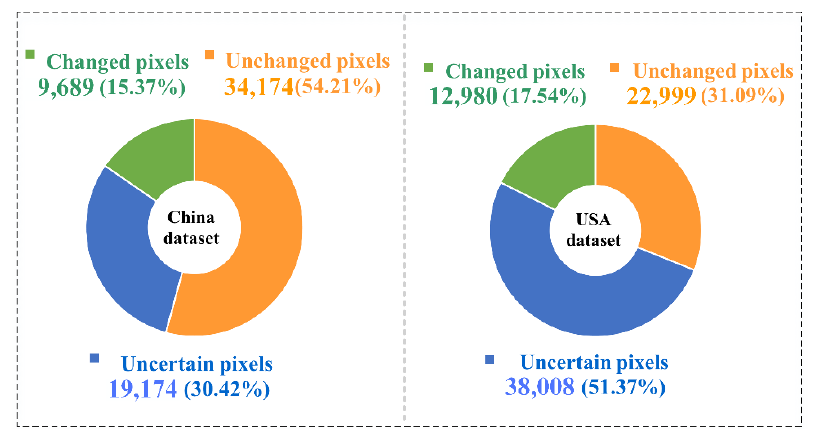
Figure 7. Statistical information of K = 3 components: unchanged pixels, uncertain pixels, and changed pixels.